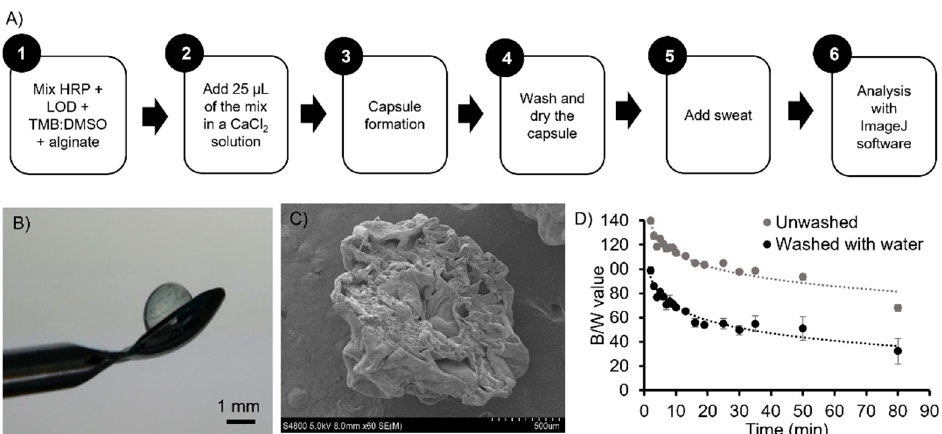
Figure 2. Alginate bead fabrication and characterisation. ( A ) Schematic diagram of the optimised fabrication protocol of the alginate beads. ( B ) Alginate bead after being washed with distilled water and dried. ( C ) SEM image of a cut alginate bead, showing its inner configuration. ( D ) Black and white values of the beads, obtained by image analysis, at different times after the addition of lactate 60 mM in artificial sweat. Values (grey dot) obtained from beads that were not washed with distilled water and dried. Values (black dot) obtained from beads washed with distilled water. Error bars correspond to mean values ± SD (n = 3).